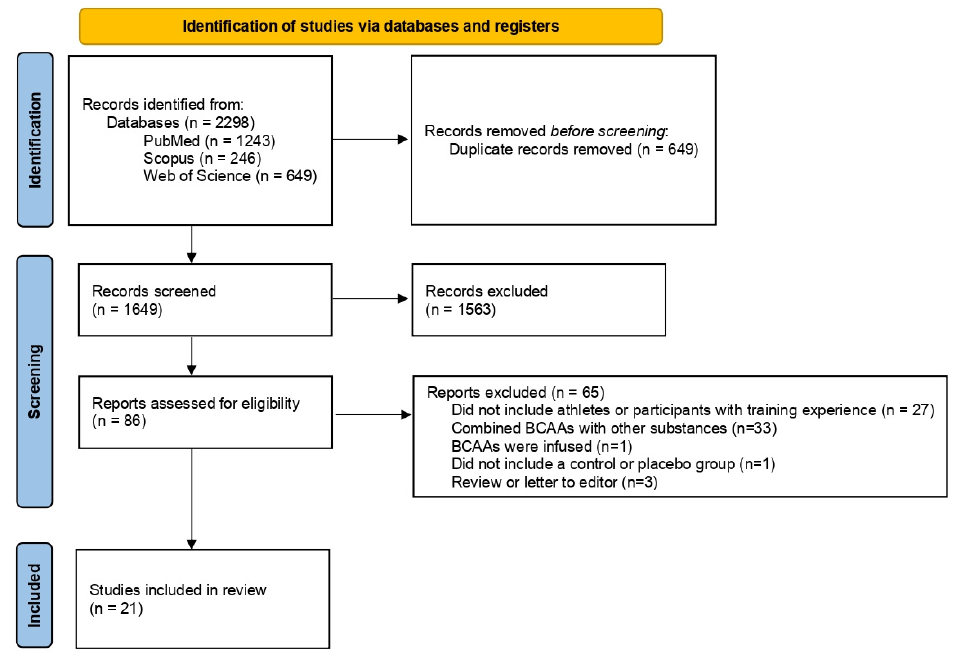
Figure 1. Flow chart diagram highlighting the studies included in the present